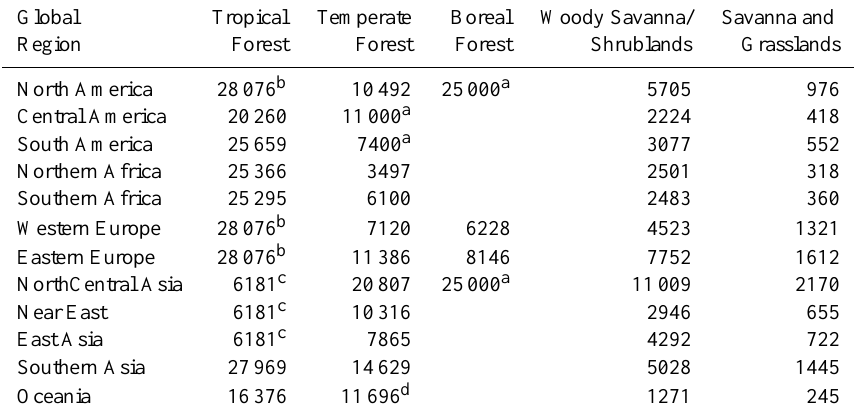
Table 2. Fuel loadings (gm − 2 ) assigned to generic land cover classifications for the global regions. These values are based on the average of the two model estimates from Table 2 of Hoelzemann et al. (2004) unless noted